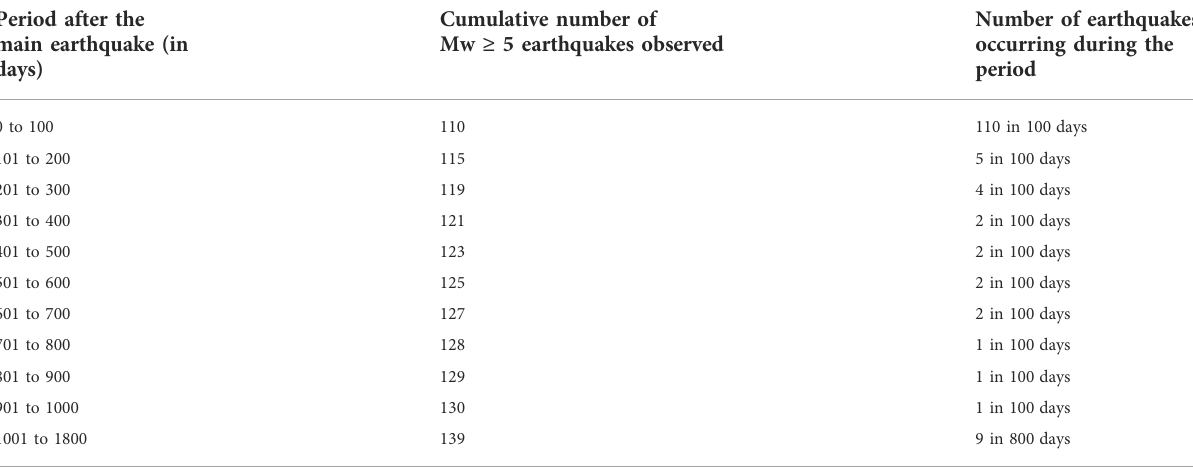
Cumulative number of Mw ≥ 5 earthquakes observed